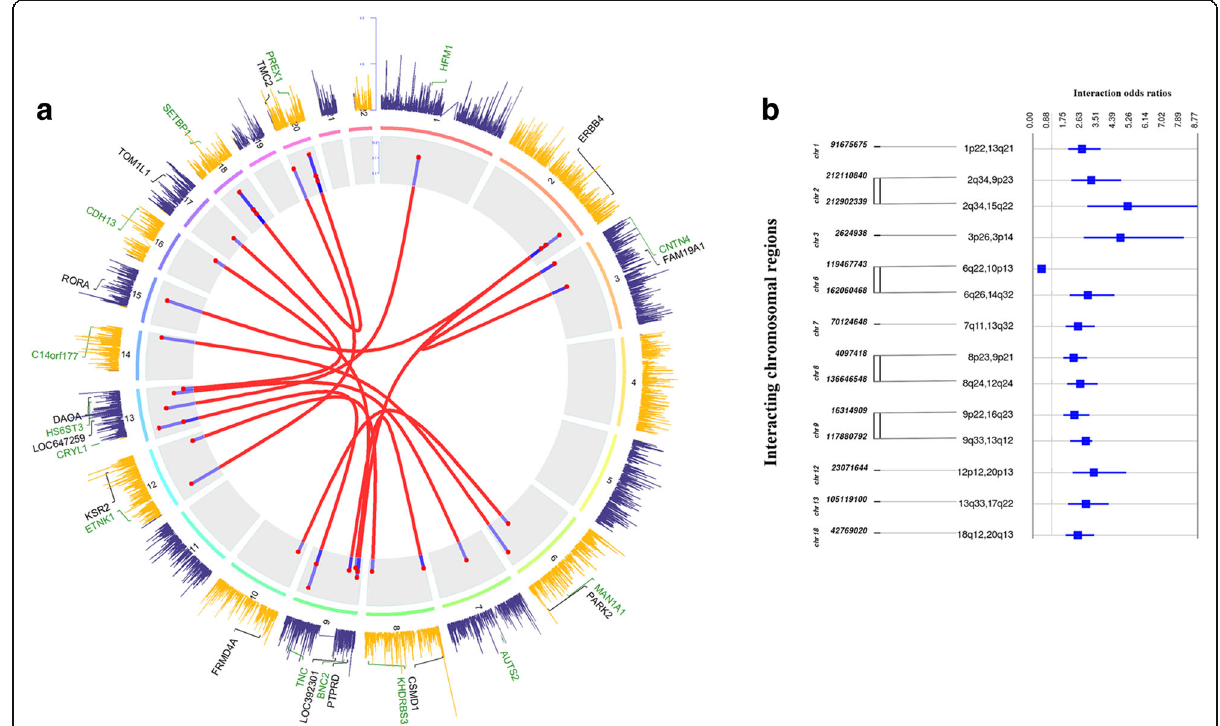
Fig. 1 Interaction Analysis identifies 14 unique risk loci pairs. a Circos plot of genome-wide association and significant interaction results for the identified paired risk loci. The second outer most panel displays results from genome-wide association study on a Manhattan plot for autosomal variants on a log transformed scale ( − log 10 ) of 1 to 8.5. Negative log transformed interaction P values corresponding to each of the interaction pair is calculated from log linear transformed regression on the discovery set and is represented on an adjusted inflated scale of 9.3 to 10.2 in the second inner most panel. More than one unique variant pair combinations are present in the same interacting regions which are marked with their corresponding odds in this panel. Genome-wide significant paired loci are line-joined in the inner most panel based on their chromosomal positions (NCBI build 19 human genome). Annotations of single nucleotide polymorphisms to gene ids are displayed at the outer most panel. b Forest plot with embedded confidence intervals for each of the identified interaction pairs. Each pair indicates two interacting chromosomal locations with base pair information for the indexing loci. Paired variants annotated to the same indexing chromosomes are line joined. chr chromosome, BP base pair; OR, odds ratio; CI, confidence